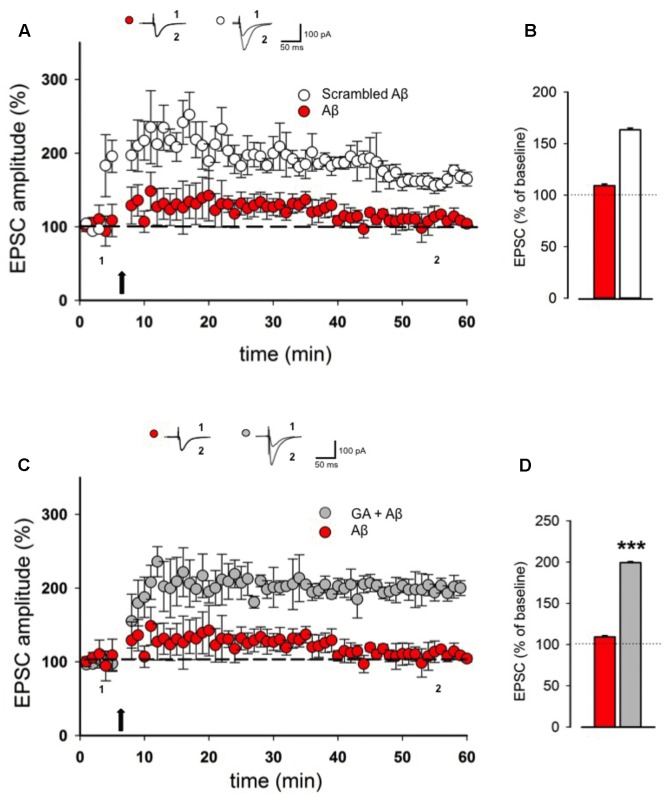
Ginkgolic acid reverses Aβ-mediated LTP impairment.
(A) Superimposed pooled data showing LTP in slices treated with Aβ or scrambled Aβ. On top, representative traces for both conditions are shown. (B) Histograms illustrating the magnitude of LTP (% of baseline) in the two experimental conditions. (C) Superimposed pooled data showing LTP in slices treated with Aβ or GA + Aβ. On top, representative traces for both conditions are shown. (D) Histograms illustrating the magnitude of LTP (% of baseline) in the two experimental conditions. ∗∗∗p < 0.001.